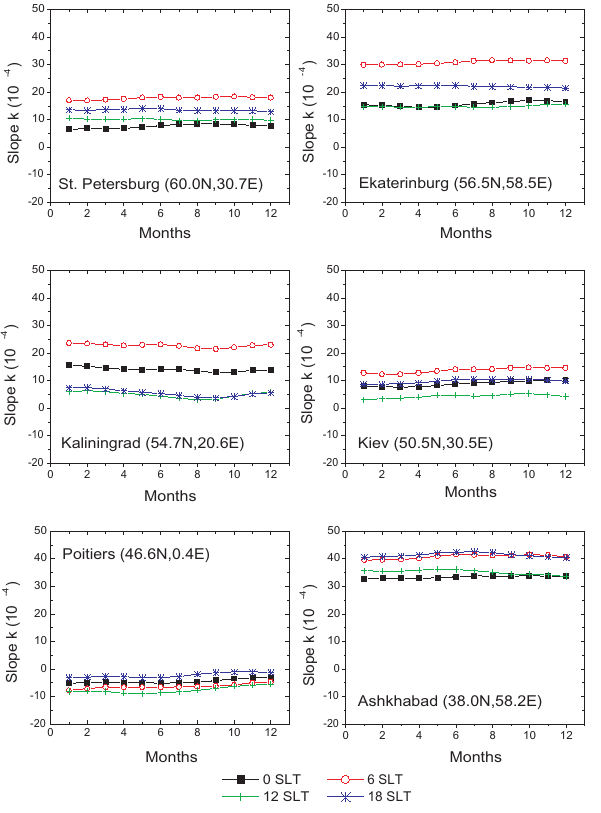
Fig. 2. Diurnal variation of the hm F2 trends when the Shimazaki (Formula 1) and the Dudeney (Formula 2) formulas were used to derive hm F2 from M( 3000 )